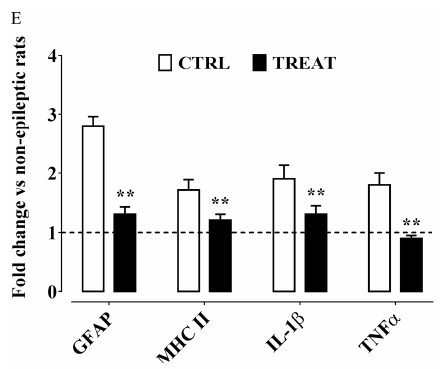
Figure 2. α -Tocopherol treatment decreases hippocampal neuroinflammation in kainate-induced status epilepticus. ( A ) GFAP (glial fibrillary acidic protein) immunoreactivity expressed as percent of area fluorescence; ( B ) GS (glutamine synthetase) immunoreactivity expressed as percent of area fluorescence; ( C ) Branch point number of Iba1 (ionized calcium-binding adapter molecule 1)-positive microglial cells; ( D ) Process length of Iba1-positive microglial cells; ( E ) Western blotting analysis of neuroinflammatory markers GFAP, MHC II, IL-1 β and TNF- α in hippocampus protein extracts obtained from CTRL and TREAT rats. Representative non-epileptic and untreated animals’ value is shown as dashed line. Statistical analyses performed by one-way ANOVA and Tukey’s post hoc test: * p < 0.05; ** p < 0.01. CTRL: kainate-exposed untreated rats. TREAT: kainate-exposed α -tocopherol treated rats. Figure modified from [276]. MHC II: major histocompatibility complex II; IL-1 β , interleukin 1 β ; TNF- α : tumor necrosis factor α .